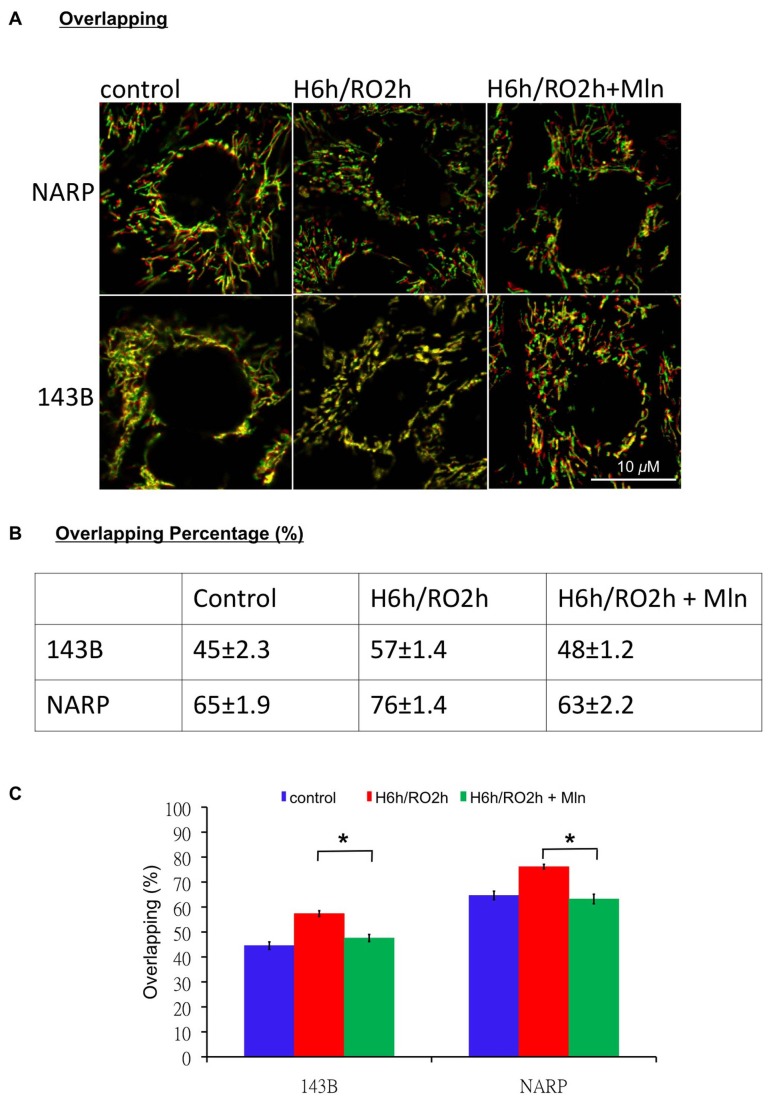
Melatonin significantly improved H/RO-induced retardation of mitochondrial movement in 143B cells and NARP cybrids.(A, B) Red/green overlay of two consecutive confocal images (Δt = 2min) of 200 nM tetramethylrhodamine methyl ester (TMRM) fluorescence in NARP cybrids and 143B cells in response to H/RO treatment without and with 100 μm melatonin. H/RO (H: 6 h; RO: 2 h) reduced the velocity of mitochondrial movement in both 143B cells and NARP cybrids, so that the percentage of nonmoving mitochondria (overlapping mitochondrial area, in yellow color) to the entire mitochondria were 57 ± 1.4% in 143B cells and 76 ± 1.4% in NARP cybrids as compared to the cells and cybrids, respectively, without H/RO treatment. Adding melatonin 100 μm during H/RO improved mitochondrial movement in both 143B cells and NARP cybrids as compared with the groups without melatonin during H/RO, so that the percentage of nonmoving mitochondria to the all mitochondria was 48 ± 1.2% in 143B cells and 63 ± 2.2% in NARP cybrids. (C) Quantitative analyses of (A). *P<0.05. n=6. Mln: melatonin.